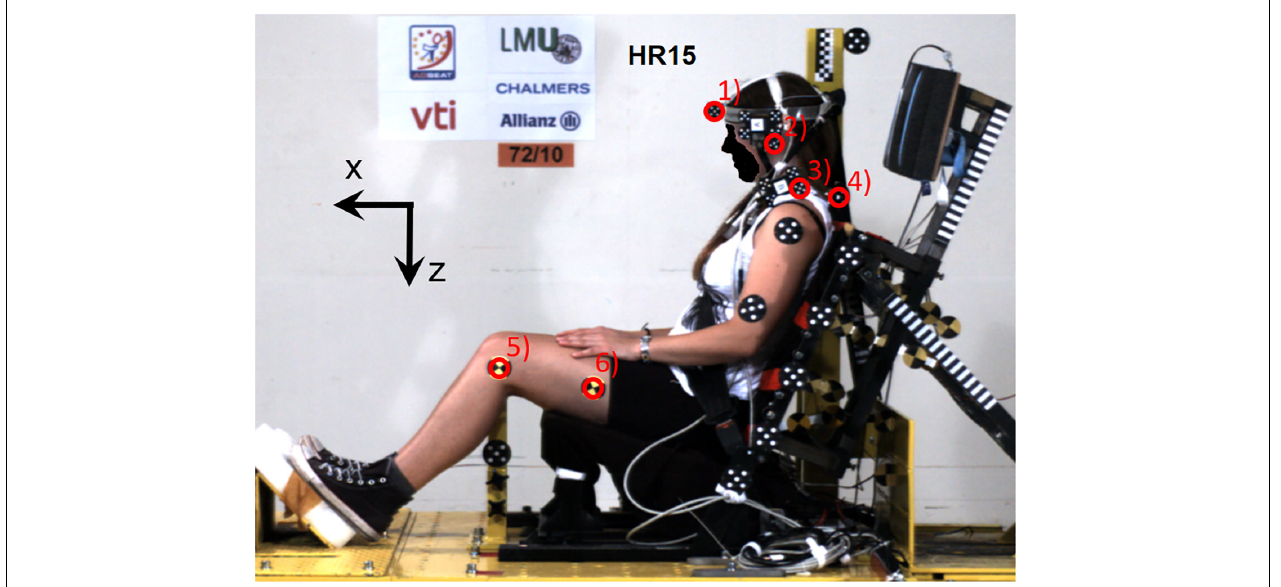
FIGURE 1 | Volunteer test setup; in this case for the head-to-HR distance 15 cm (HR15). Video tracking targets (1) and (2) for determining head displacements and targets (3) and (4) for T1 displacements. The position of the trochanter major was palpated and measured prior to the test, and its linear displacement was obtained from targets (5) and (6) . The thickness of the dark head restraint padding was adjusted to adapt the head-to-head restraint distance for each volunteer, to either 10 cm or 15